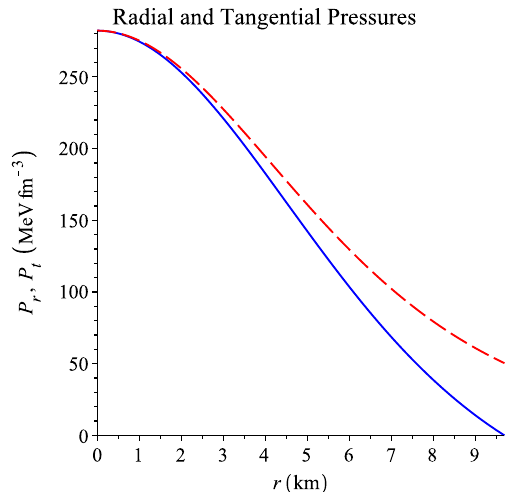
Fig. 3 Plot of radial and tangential pressures P r , P t in MeV fm − 3 for the parameter values used in Fig. 1. The solid (blue) line corresponds to P r , and the dashed (red) line corresponds to P